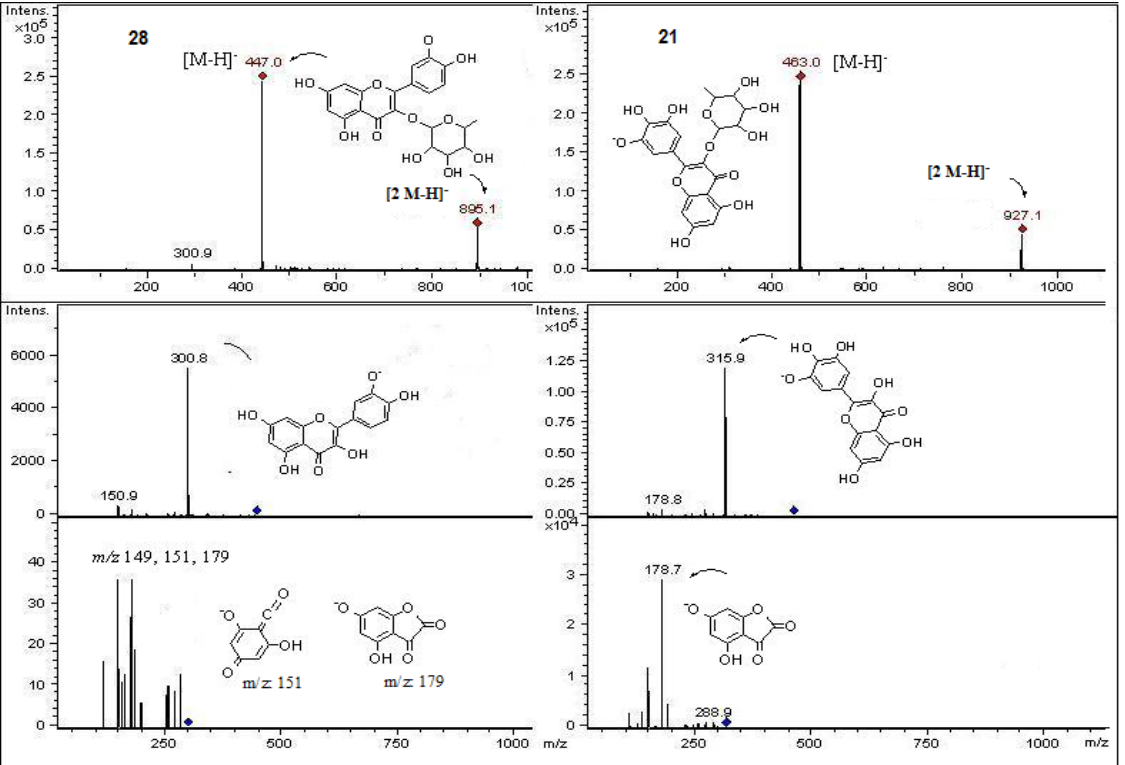
Figure 9. Structures, fragmentation, full ESI-MS and MS-MS spectra of peaks 21 and 28